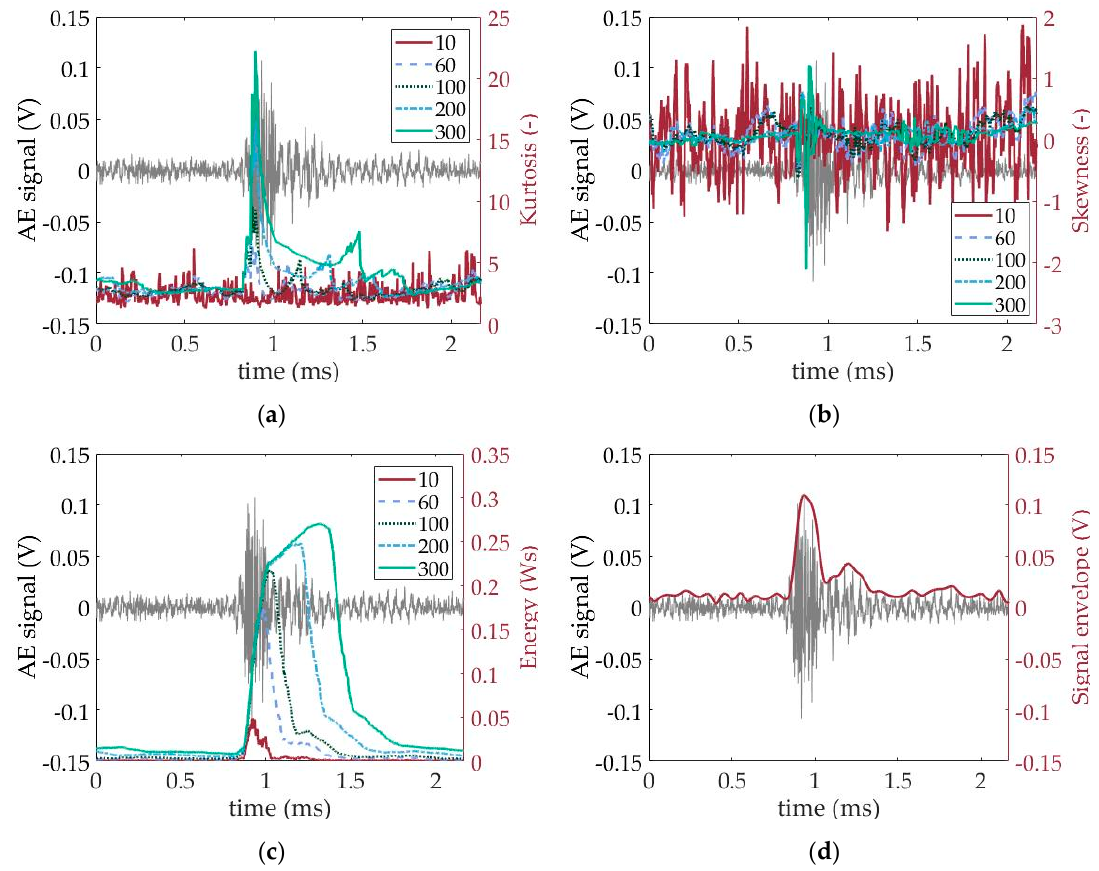
Figure 4. Influence of the position of different window lengths against the AE signal on the teaching properties’ values: kurtosis ( a ); skewness ( b ); energy ( c ); upper envelope ( d ); the recorded signal wavelength is in the background.